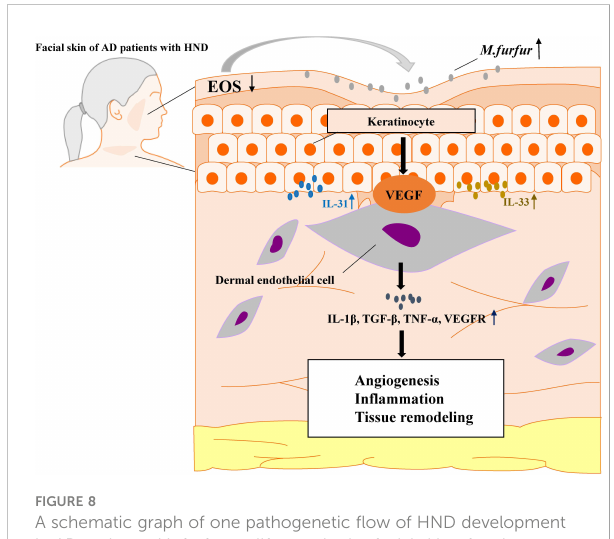
FIGURE 8 A schematic graph of one pathogenetic fl ow of HND development in AD patients. M. furfur proliferates in the facial skin of patients suffering from HND due to decreased levels of ceramide, which induce keratinocytes to secrete Th2 cytokines (IL-31, IL-33) and vascular endothelial growth factor (VEGF), thereby causing dermal endothelial cells to produce various cytokines to induce angiogenesis, exacerbating eczematous in fl ammation and tissue